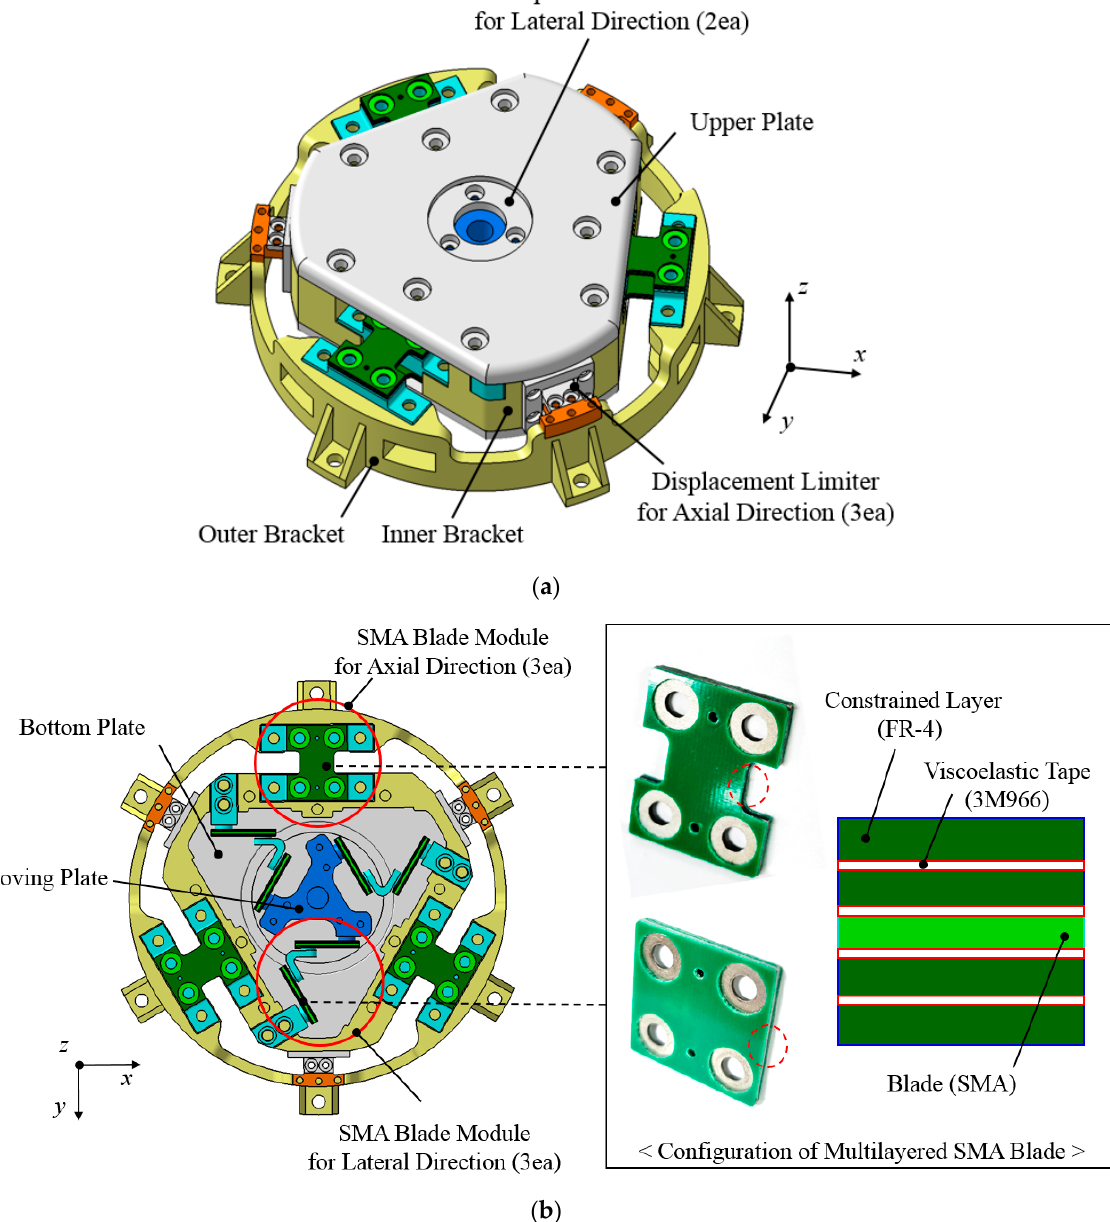
Figure 1. Configuration of the Proposed WSVI (( a ) Isometric View, ( b ) Inside View). In addition, multilayered thin metal plates with viscous lamina tapes were utilized to increase the damping capability, which also helped distribute the stress release acting on the thin SMA blade. The proposed WSVI is mainly composed of SMA blade modules to achieve the required target cut-off frequency in the axial and lateral directions, a moving plate, upper and bottom plates, inner and outer brackets, and displacement limiters to limit the movement of the blades to within their allowable deflection range. The stiffness of the vibration isolator for each axis is significantly governed by the SMA blade